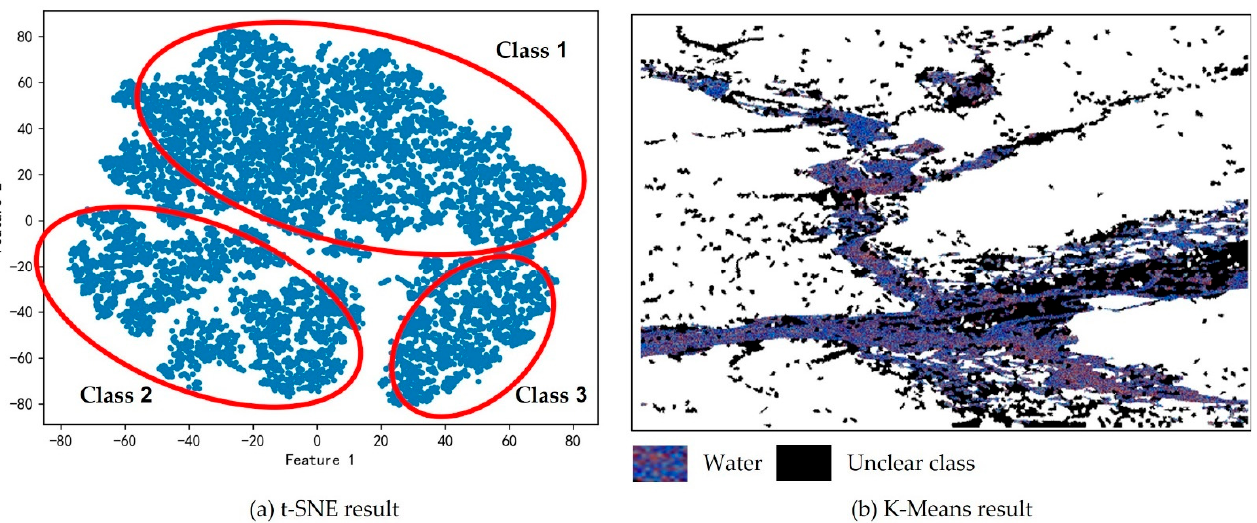
Figure 10. Study area 1 classification results of ( a ) superpixel-based GNN, ( b ) superpixel-based RF, ( c ) superpixel-based XGBoost, ( d ) pixel-based Ostu, ( e ) pixel-based RF, and ( f ) pixel-based XGBoost. ( g ) shows the ground truth.